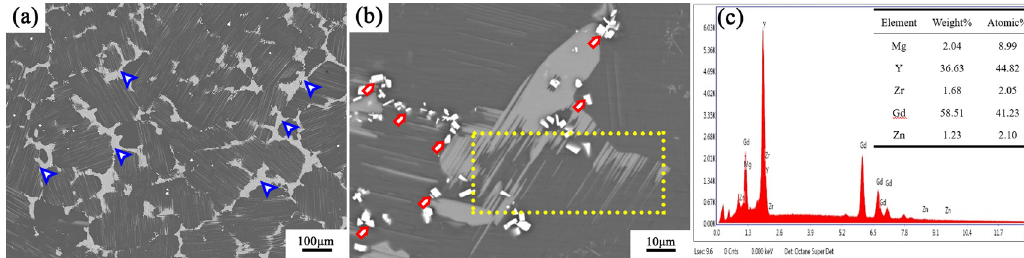
Figure 2. Backscattered electron (BSE) images of the alloy after homogenization: ( a ) overall microstructure; ( b ) block-shaped phase; ( c ) EDS result of the precipitate